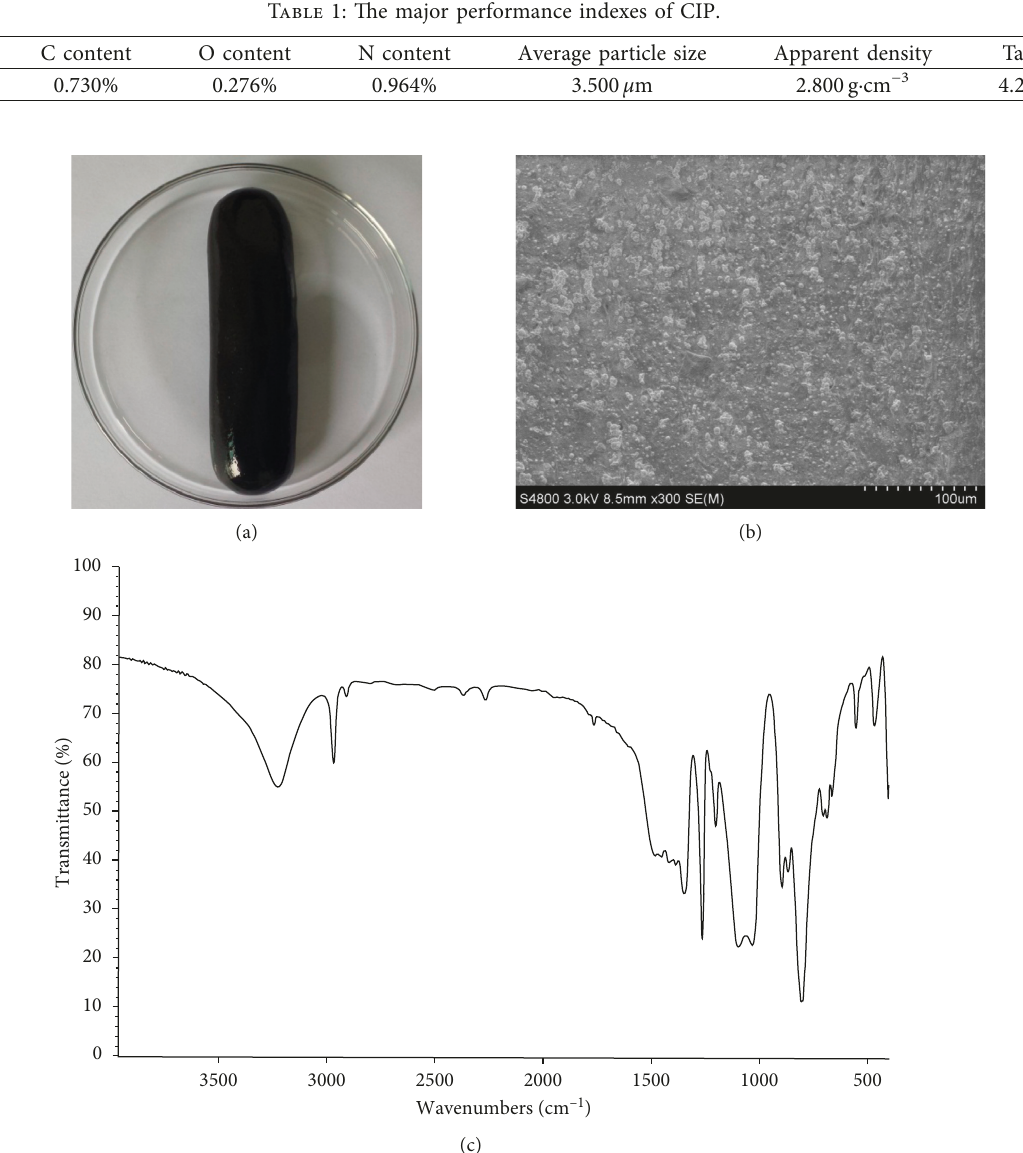
Figure 1: (a) The MRSP sample at a room temperature, (b) SEM image of the internal microstructure, and (c) FTIR spectrum in the range of 4000–500cm − 1